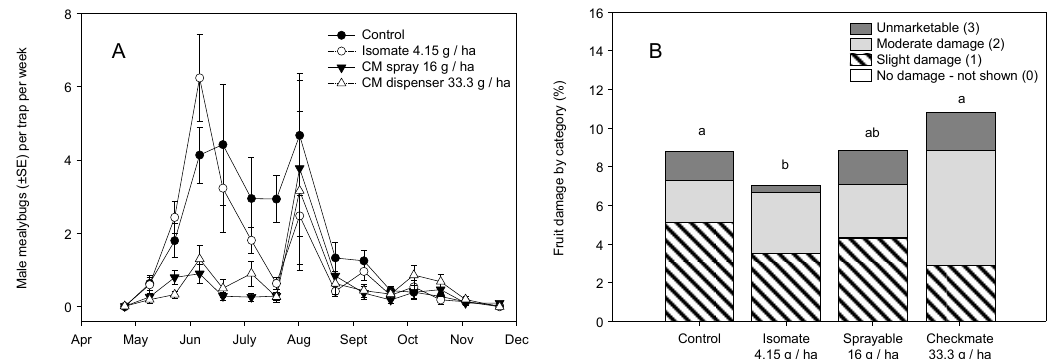
Figure 4. 2005 field studies of season-long adult male Pl. ficus (mean ± SEM) captures in pheromone-baited traps in plots with ( A ) Isomate dispensers (Scentry Inc.) hung at rates of 4.15 g a.i./ha and CheckMate Flowable formulation applied two times for a rate of 16 h a.i./ha and CheckMate dispensers hung at 19.8 g a.i./ha; ( B ) the categorical ranking of mealybug damage to fruit clusters at harvest time across all treatments (different letters above each bar represent significant differences, pairwise comparisons using an experiment-wide error rate of p < 0.01.).